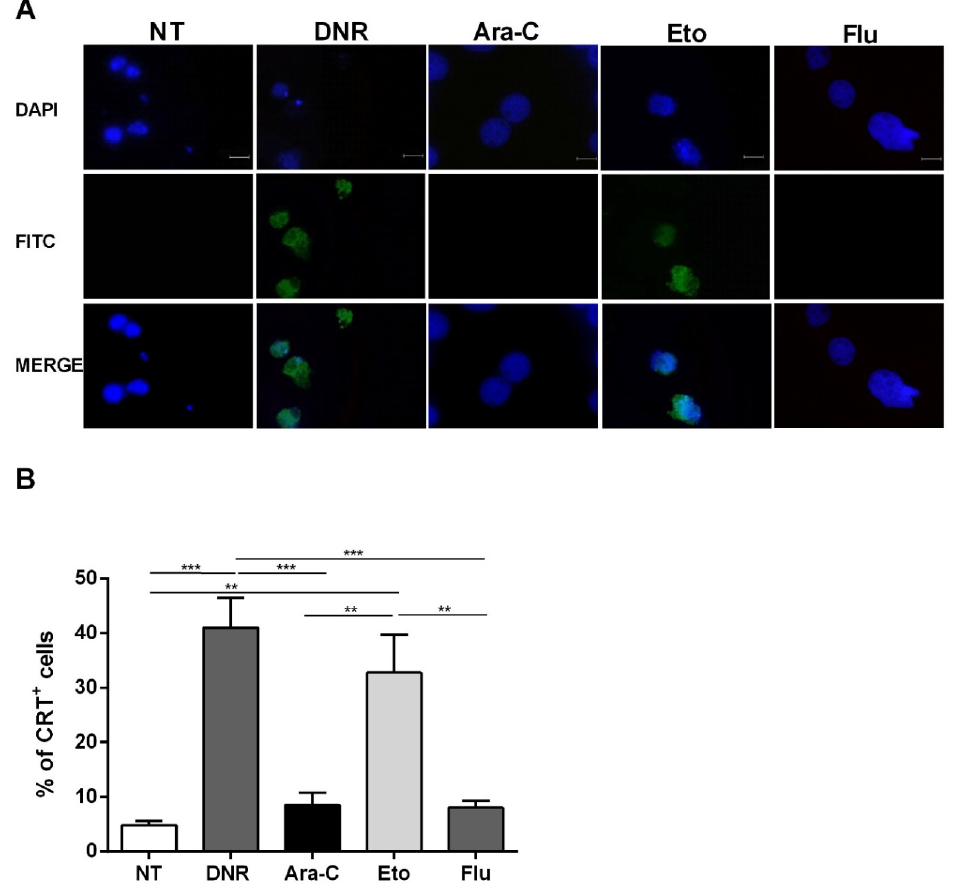
Figure 3. Immunofluorescence analysis of calreticulin (CRT) translocation on the cell-surface of HL-60 cell lines after chemotherapy treatment. The HL-60 cells were treated or not (no treatment; NT) with daunorubicin (DNR) (500 ng/mL), cytarabine (Ara-C) (20 µg/mL), etoposide (Eto) (20 µg/mL) and fludarabine (Flu) (70 µg/mL) for 24 h. ( A ) The localization of CRT (FITC-conjugated) at cell membrane level with respect to the nucleus (DAPI-conjugated) was evaluated by immunofluorescence microscopy. One representative experiment for each drug is reported. Bar 20 µm. ( B ) Quantitative analysis of CRT + cells by immunofluorescence. A total of 100 cells were used for the quantification. ** p < 0.01; *** p < 0.001. 2.3. Only Treatment with DNR and Eto, but Not Flu and Ara-C, Induced the HMGB1 Release from the Nucleus to the Extracellular Space of AML Cells After cellular stress, during the late post-apoptotic phase, pro-inflammatory nuclear factor HMGB1 translocates to the cytosol and is consequently released to the extracellular space [12]. After binding to specific receptors on DCs, HMGB1 induces the full maturation of DCs as evaluated by the up-regulation of CD40, CD54, CD80, CD83 and MHC II. To test this event, the HL-60 cells were treated with DNR (500 ng/mL), Ara-C (20 µg/mL), Eto (20 µg/mL) or Flu (70 µg/mL) for 24 h, then fixed, permeabilized, stained and analyzed for HMGB1 expression by immunofluorescence microscopy. As shown in Figure 4A, the extracellular release of HMGB1 was well-documented after DNR and Eto, but not after Ara-C and Flu, similarly to what was observed for CRT and HSP induction. These results were also confirmed when the HMGB1 expression density between un-treated and treated cells was evaluated (Figure 4B).